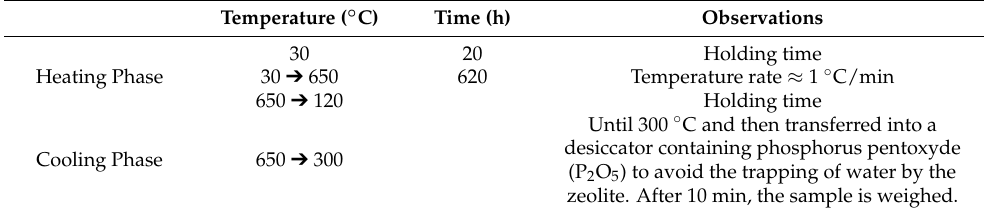
Table 8. Oven temperature program for the calcination of composite